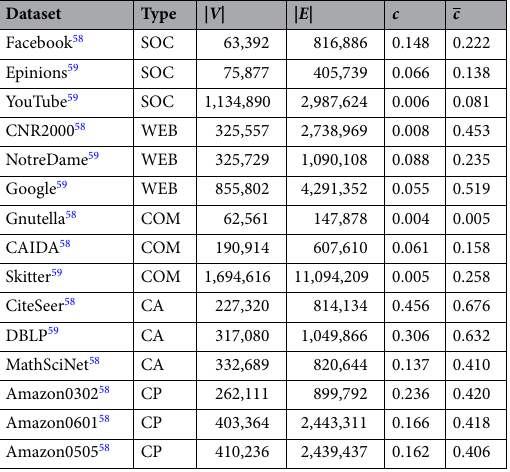
Table 2. Real-world network